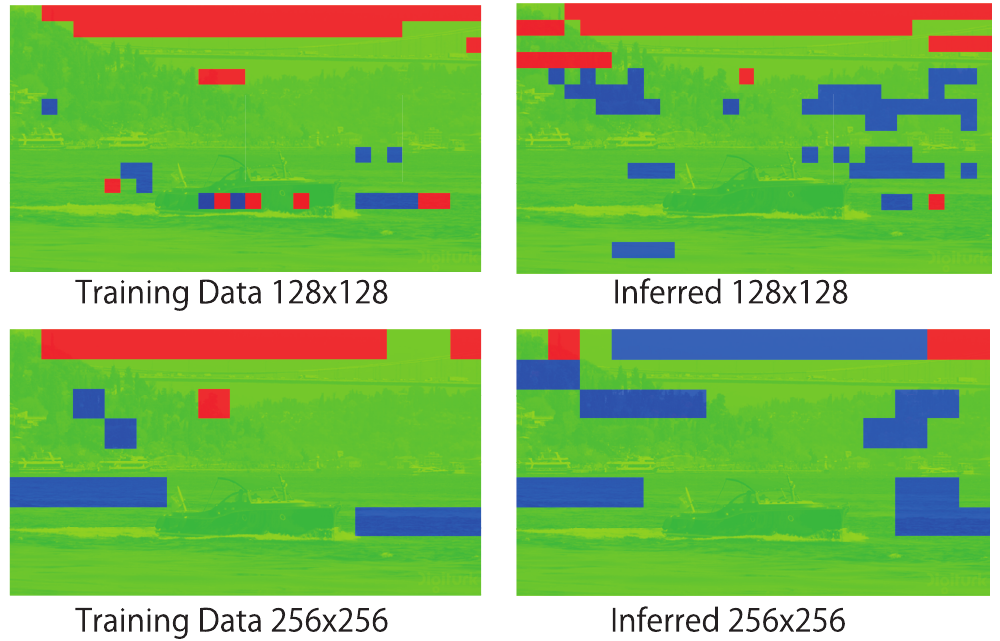
Figure 10. Comparisons among distributions of compression programs used for training and inferred by DNN